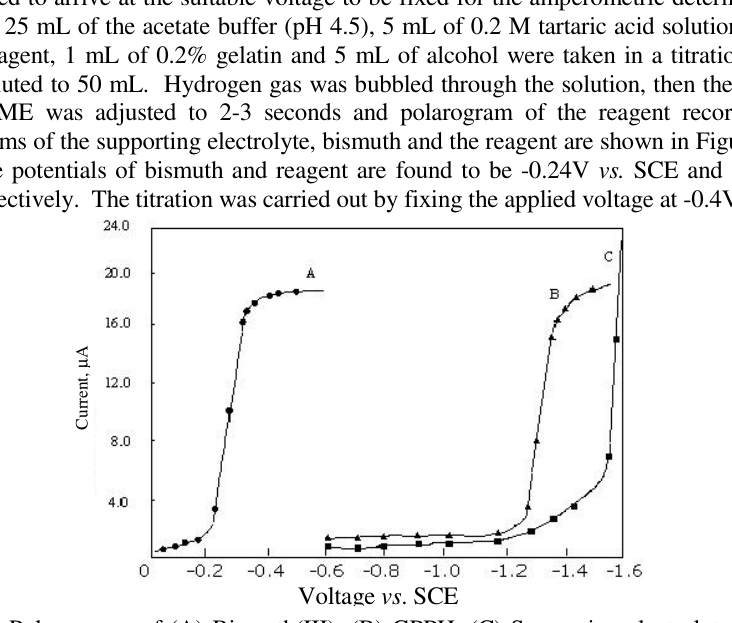
Figure 1. Polarograms of (A) Bismuth(III); (B) GPPH; (C) Supporting electrolyte (pH= 4.5, acetate